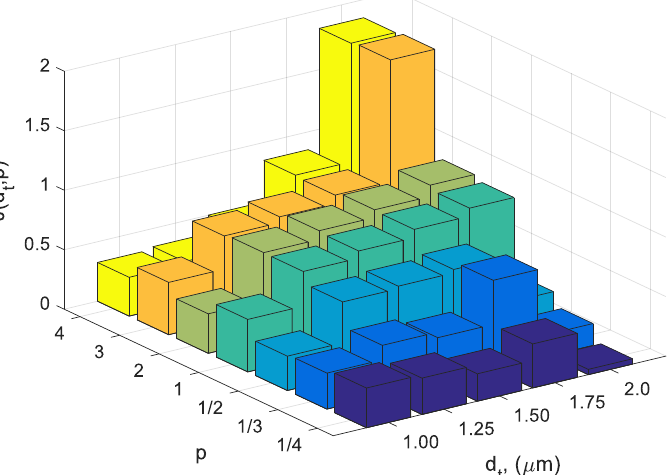
Figure 8. Quality criterion J ( d t , p ) as a function of parameter ( p ) and thickness of gradient layer ( d t ).